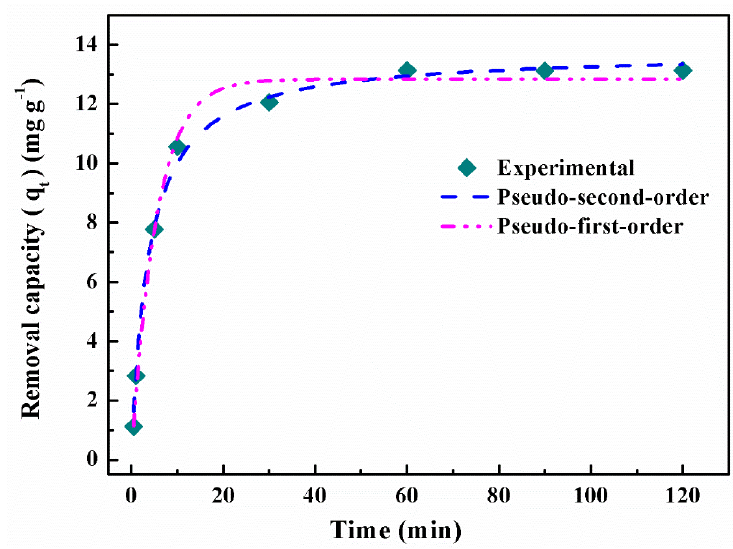
Figure 5. Effect of contact time on As(V) adsorption.